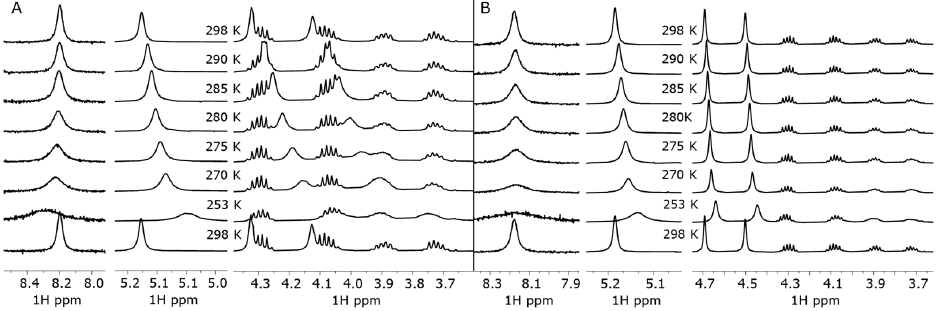
Figure 6. The selected areas of 1 H-NMR spectrum of 1:1 ratio mixture of 1.0 × 10 − 3 M bis-ZnOEP and ( A ) ( R , R )- cycHC[6] and ( B ) ( R , R )- cycHC[8] at (from top to bottom): 298 (before cooling), 290, 285, 280, 275, 270, 253, and 298 K (after heating back to initial temperature).